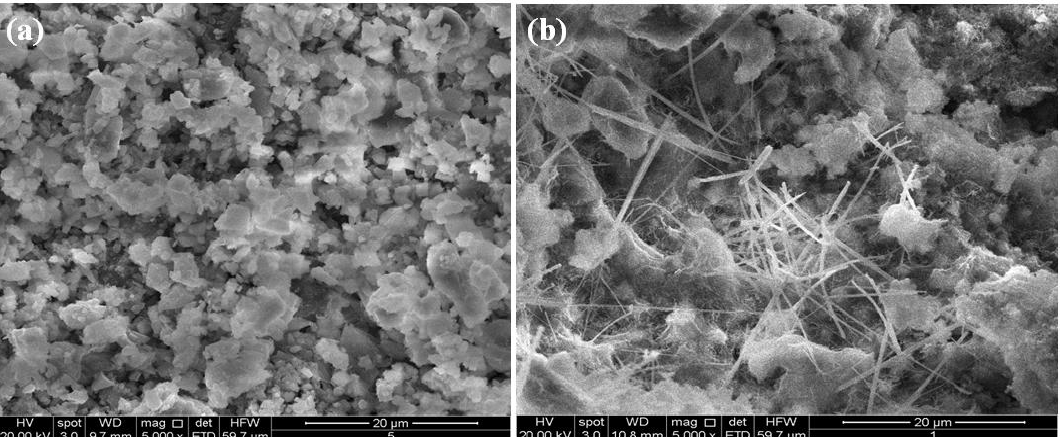
Figure 10. SEM micrographs (5000×) of the systems M1 ( a ) and M7 ( b ) after 28-day